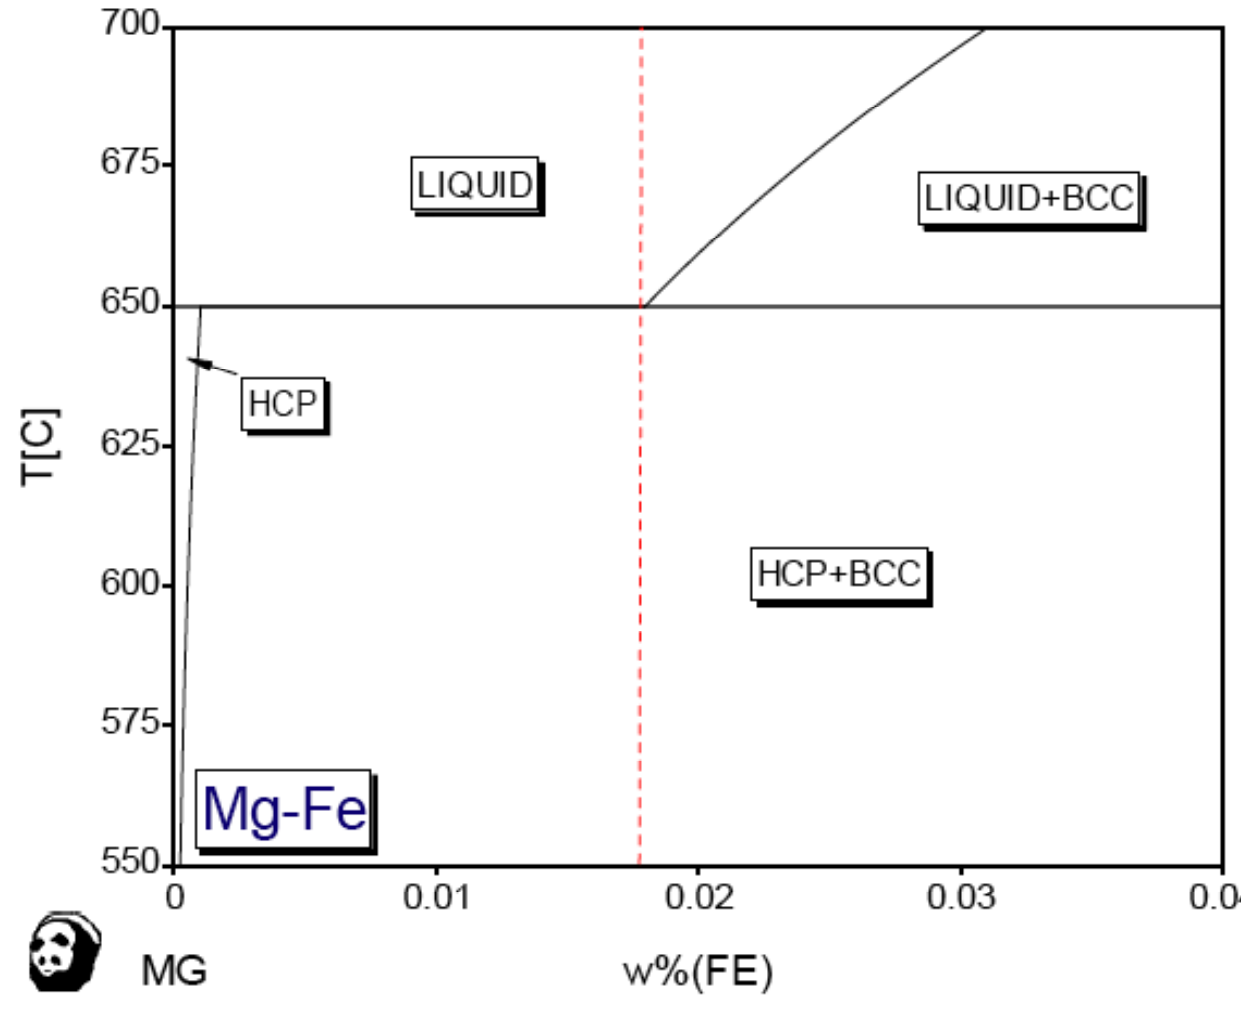
Figure 7. The Mg-Fe equilibrium phase diagram is a eutectic phase diagram